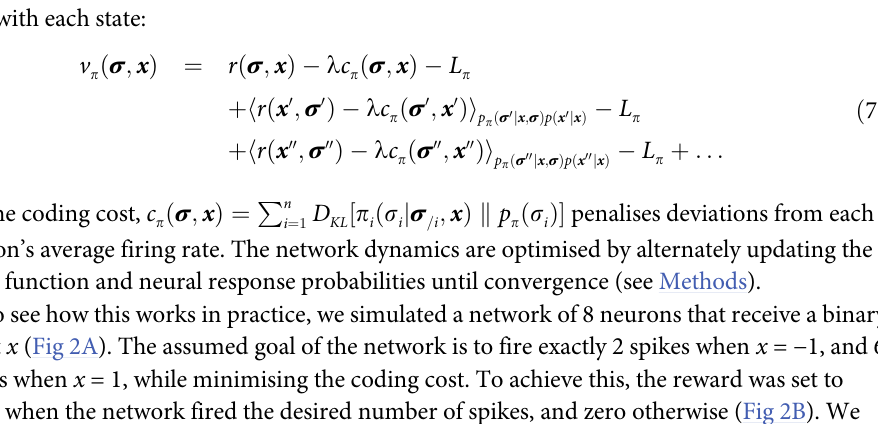
PLOS ONE | https://doi.org/10.1371/journal.pone.0248940 April 15,